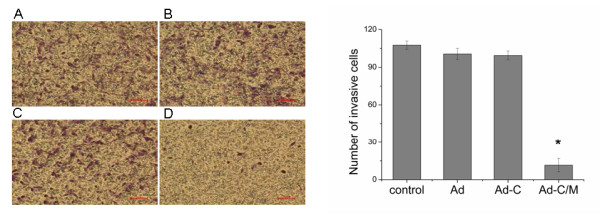
Transfection of Ad-CALR/MAGE-A3 attenuated the invasion ability of glioblastoma cells in vitro. Using matrigel coated invasion chambers, cell invasion ability was observed. The invading cells were fixed with cold methanol, and then stained with crystal violet. Representative microscopy images of the invasion assay are shown (×100). (A) - (D):Photomicrographs showing representative views of cell invasion assays. In the presence of Ad-CALR/MAGE-A3, the number of invading U87 (D) was smaller than those of U87 (A), U87/Ad-vector (B) cells and U87/Ad-CALR(C). Scale bars = 100 μm. (E): Bar represents the mean number of the cells per field. The invasion assay was consistent with the migration assay and showed that the transfection of Ad-CALR/MAGE-A3 attenuated the invasion ability of glioblastoma cells. *p < o.o5.